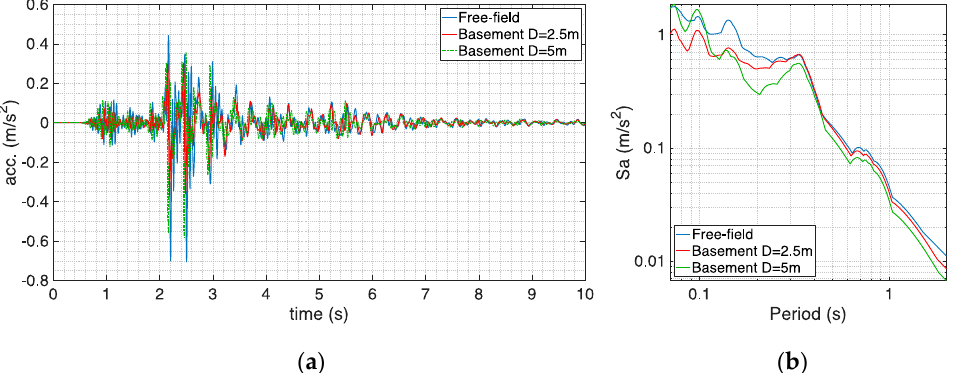
Figure 15. Comparison between surface free-field motion and signals at basement level (two different depths) for BOWW soil profile and record “Accel borehole” in terms of acceleration ( a ) histories and ( b ) response spectra.